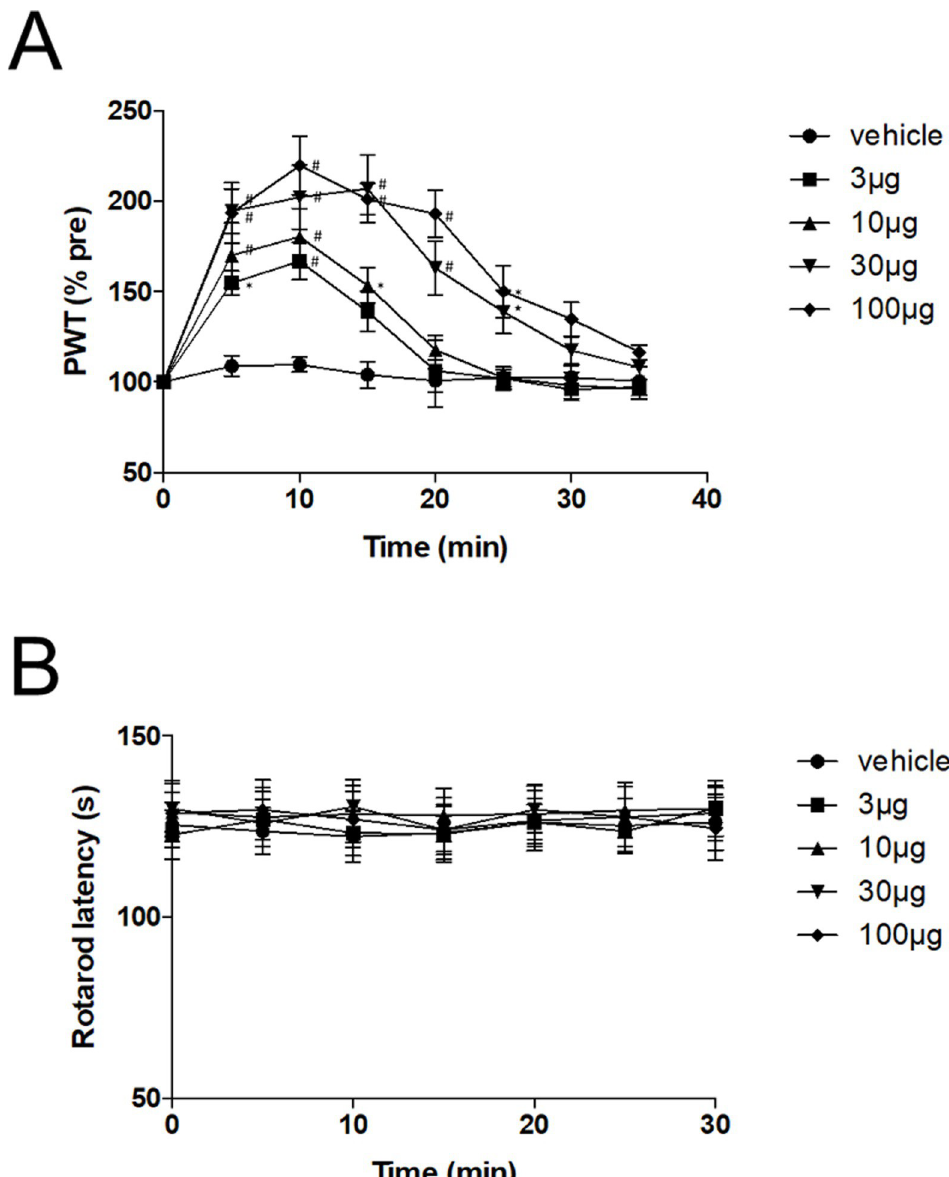
Fig 1. Effects of intrathecal administration of ML297 on mechanical nociception. (A) ML297 increased the paw withdrawal threshold in a dose-dependent manner. Significant effects were seen at 3 μ g and higher doses. Data are mean ± SEM of the pre-injection baseline levels (n = 6 rats/group). � P < 0.01, # P < 0.001, compared to the vehicle at corresponding time points. (B) Effects of intrathecally administered ML297 on motor performance in the rotarod test. ML297 did not affect motor performance at concentrations up to 100 μ g. Data are mean ± SEM (n = 6